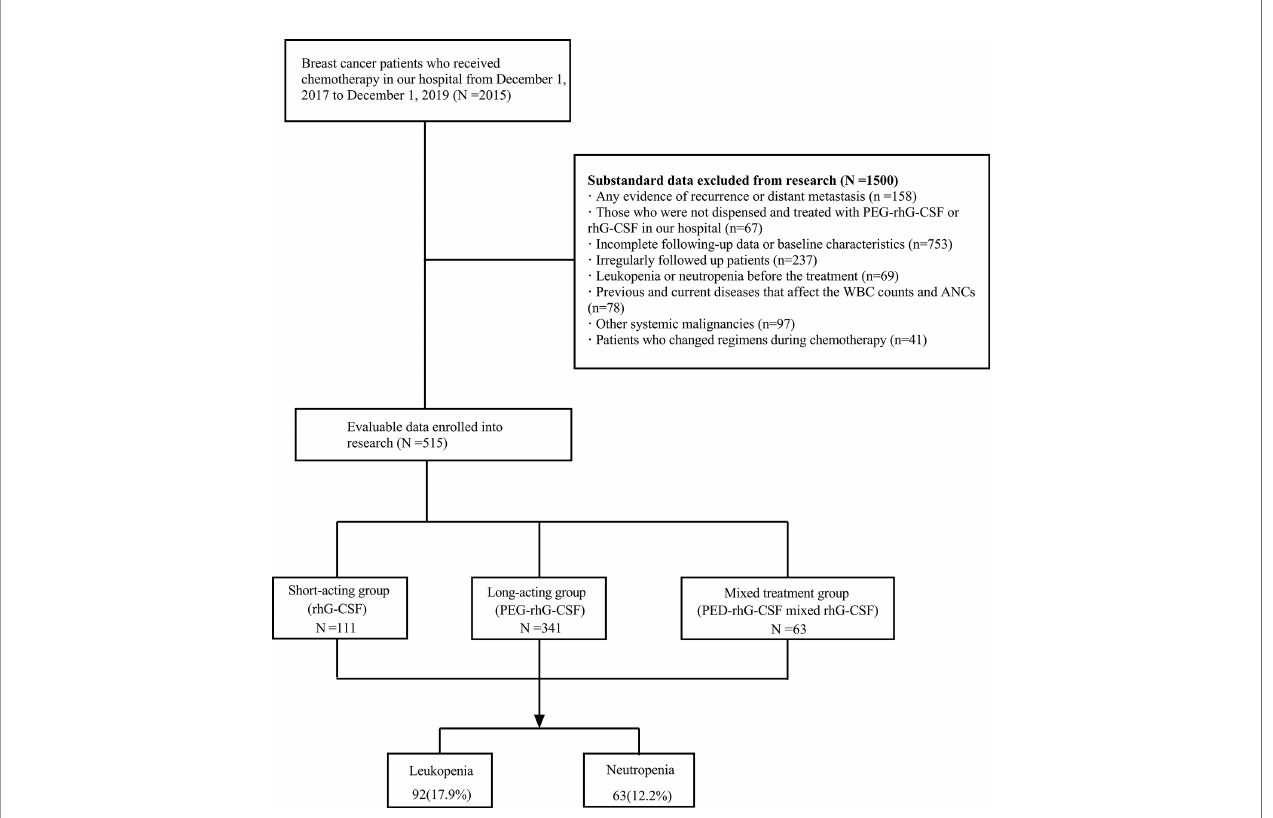
FIGURE 1 | Diagram of the participants included and excluded in analyses. This study collected 2015 breast cancer patients who received chemotherapy in our hospital from November 1, 2017, to November 1, 2019. Among them, 1,500 did not meet the criteria, and 515 were fi nally enrolled. PEG-rhG-CSF, pegylated recombinant human granulocyte colony-stimulating factor; rhG-CSF, recombinant human granulocyte colony-stimulating factor; N,